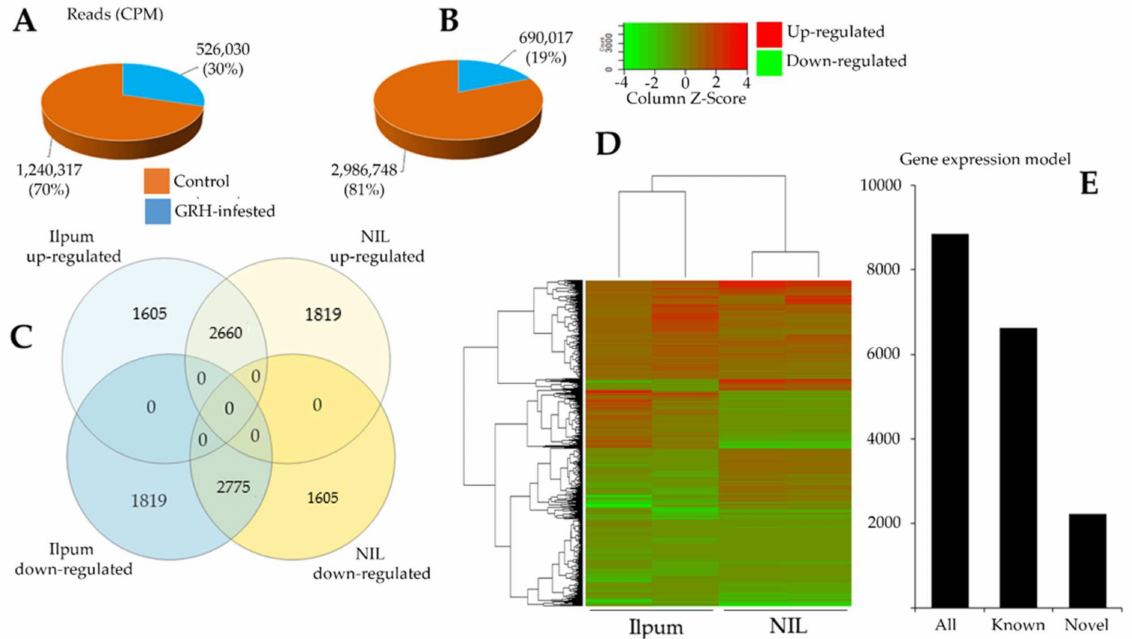
Figure 3. Differentially expressed genes of green rice leafhopper (GRH)—responsive genes between Ilpum and near-isogenic line (NIL). Reads count in ( A ) Ilpum and ( B ) NIL control and GRH-treated plants; ( C ) up- and downregulated genes in Ilpum and NIL; ( D ) heat map showing differentially expressed genes (DEGs) between Ilpum and near-isogenic line (NIL) in response to GRH in duplicate (two samples sequenced per rice line for nontreated and GRH-infested seedlings. Data used to generate the heat map are expressed as Log 2 FC); ( E ) gene expression model. Log 2 FC, logarithm base 2 of the fold change calculated from the fragment per kilobase of transcript per million mapped reads (FPKM